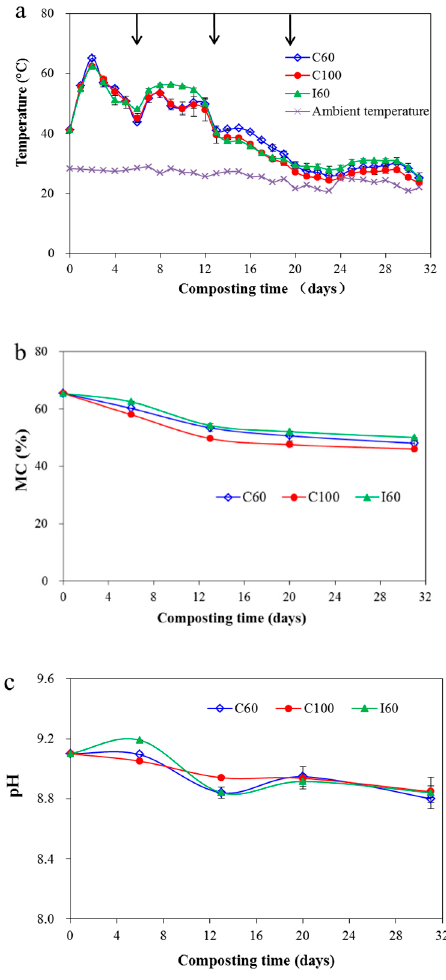
Figure 3. Changes of temperature ( a ), MC ( b ) and pH ( c ) during the composting of cattle manure. Results are the mean of three replicates and error bars indicate standard deviation. Arrows indicate the time of turning. For abbreviations see Figure 1.